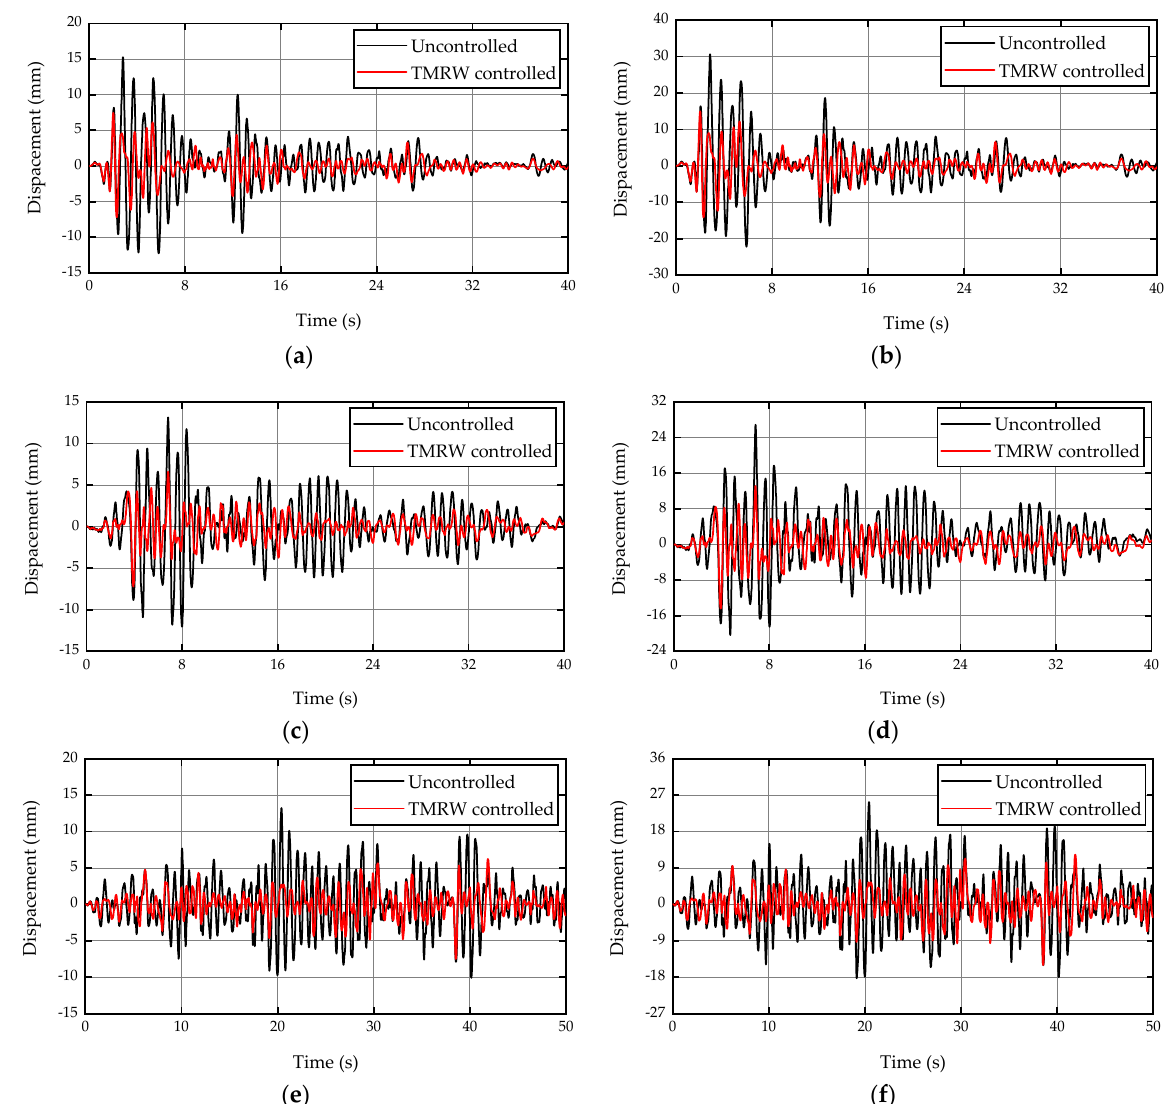
Figure 12. Comparison of the displacement responses (the second floor): ( a ) El Centro earthquake excitation (0.1 g); ( b ) El Centro earthquake excitation (0.2 g); ( c ) Taft earthquake excitation (0.1 g); ( d ) Taft earthquake excitation (0.2 g); ( e ) Wenchuan earthquake excitation (0.1 g); ( f ) Wenchuan earthquake excitation (0.2 g). Table 1. Control effectiveness of the displacement responses (the second floor).